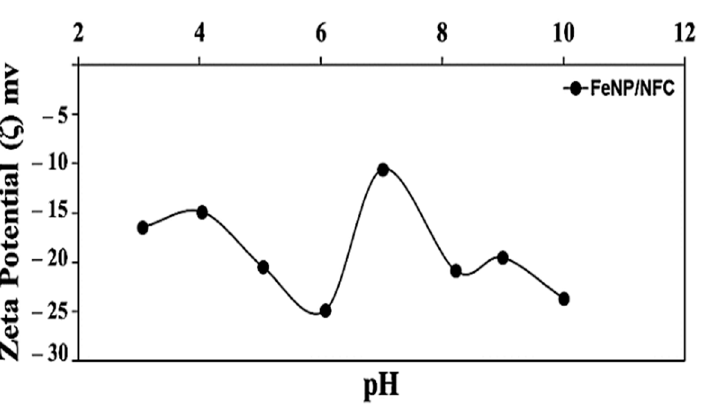
Figure 6. Zeta potential (ZP) of FeNP/NFC composite.